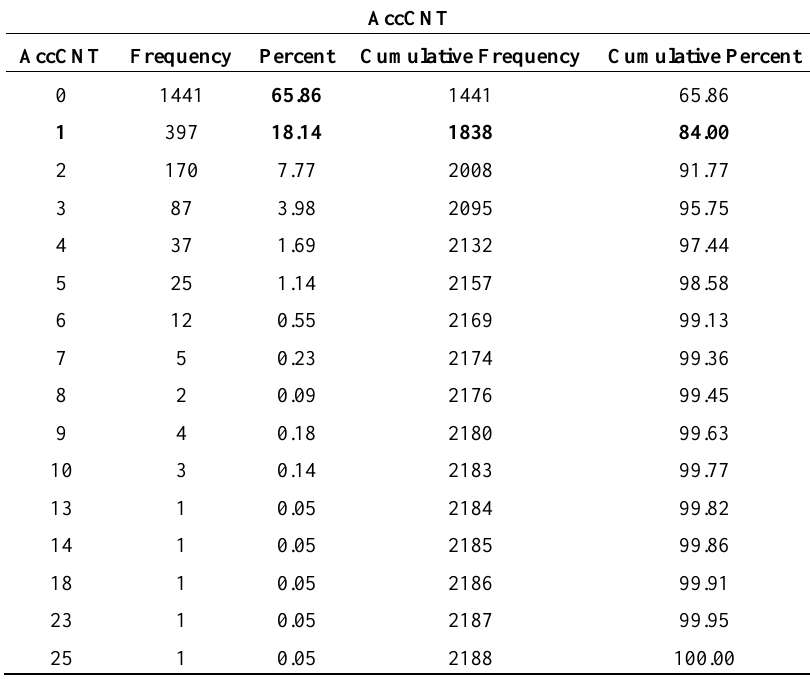
Table 6. Real data accident proportions for N accidents (road segments of 500 m in